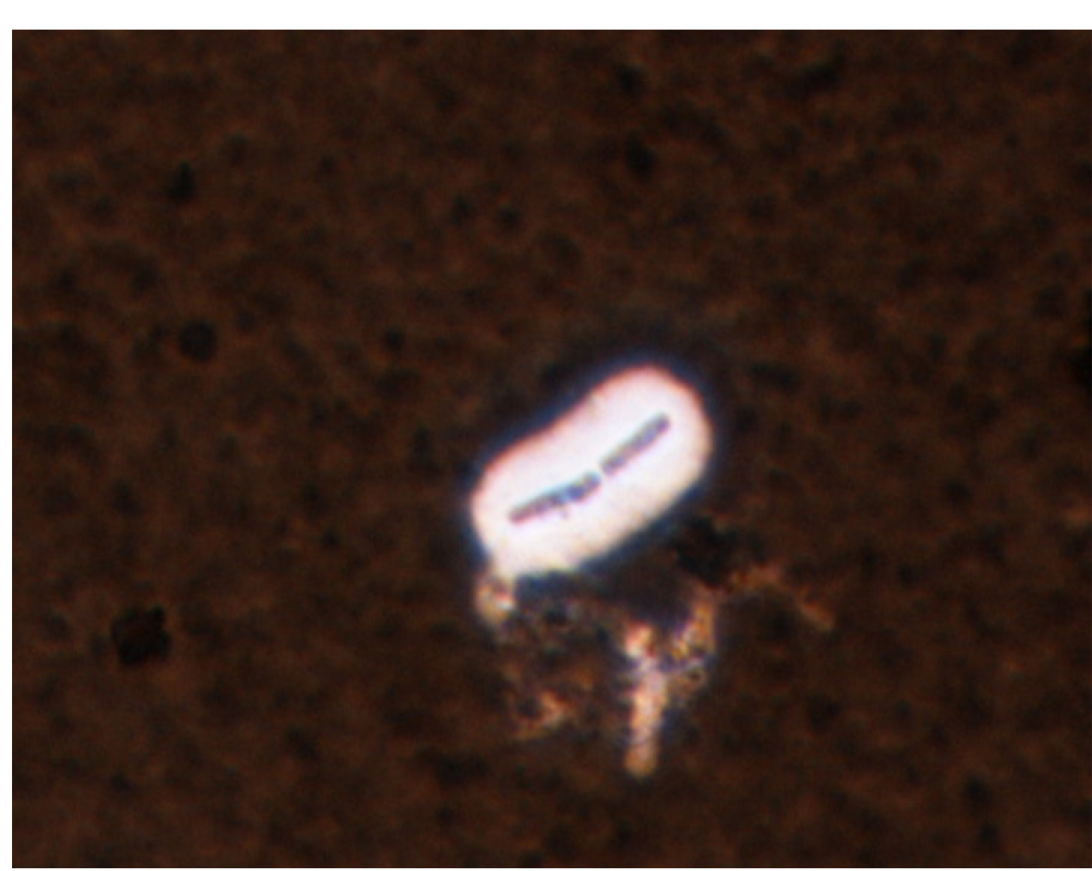
Fig 2. B . cereus BcFL2013 capsule. India ink stain of B . cereus BcFL2013 after overnight growth in defibrinated horse